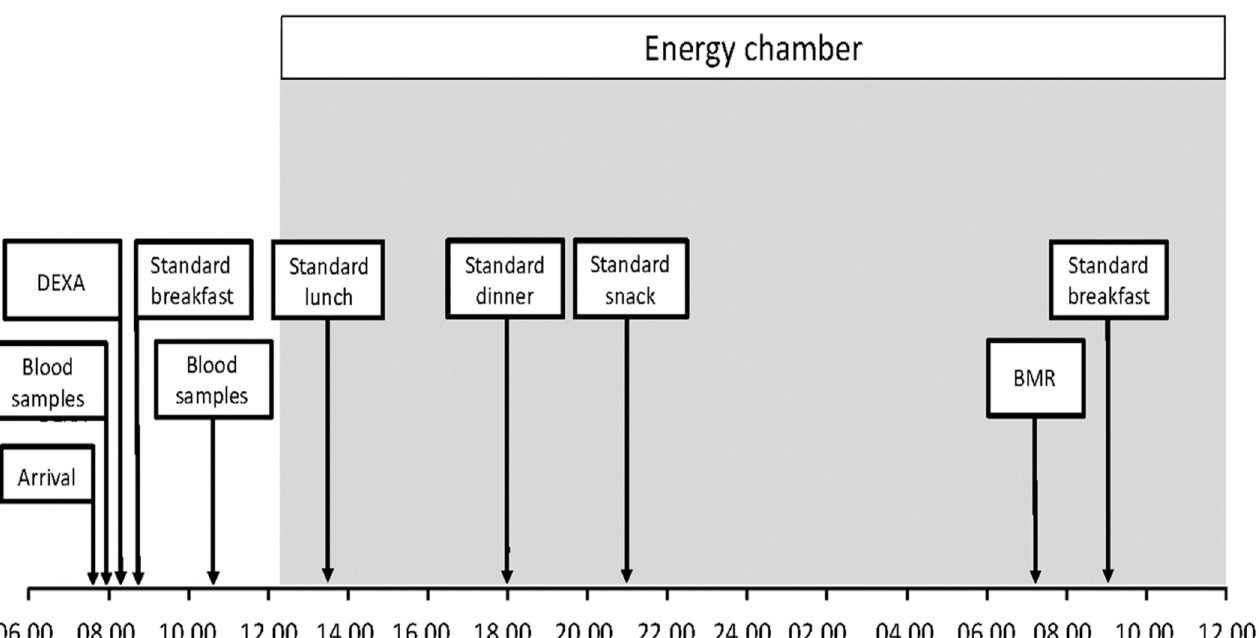
Fig 1. Protocol during study visits before as well as 10 days, 3 months and 20 months after gastric bypass surgery for six female study